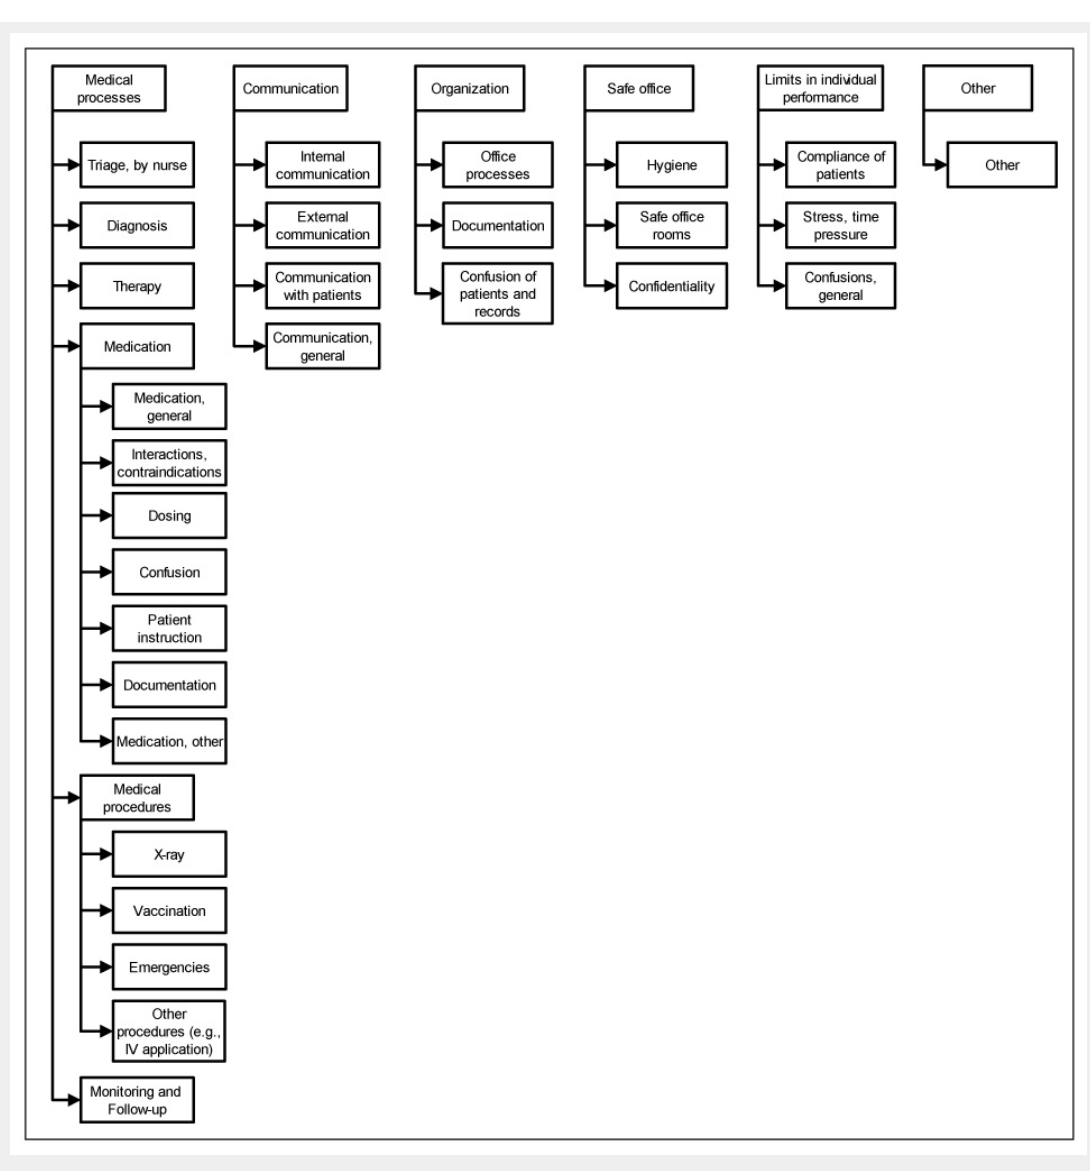
Figure 1 Category system for coding citations of priority threats to patient